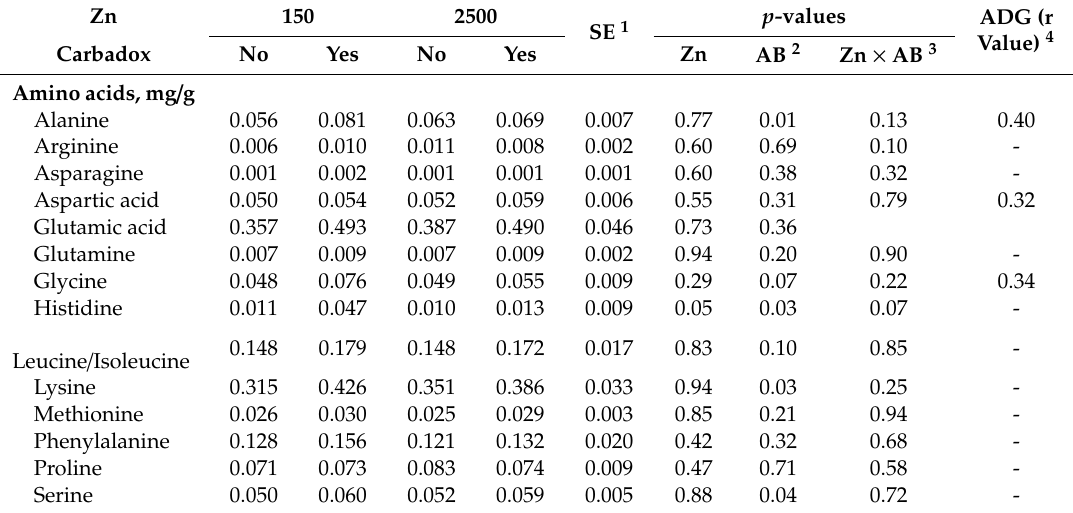
Table 4. E ff ect of Zn concentration and carbadox on AA, FA, and BA in